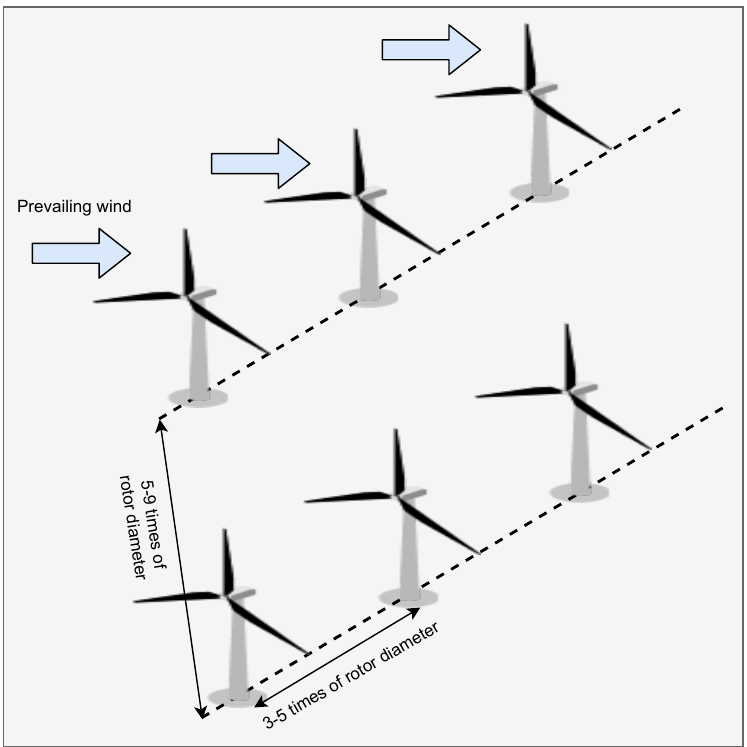
Figure 11. Optimum spacing between WTs for a WF as suggested in